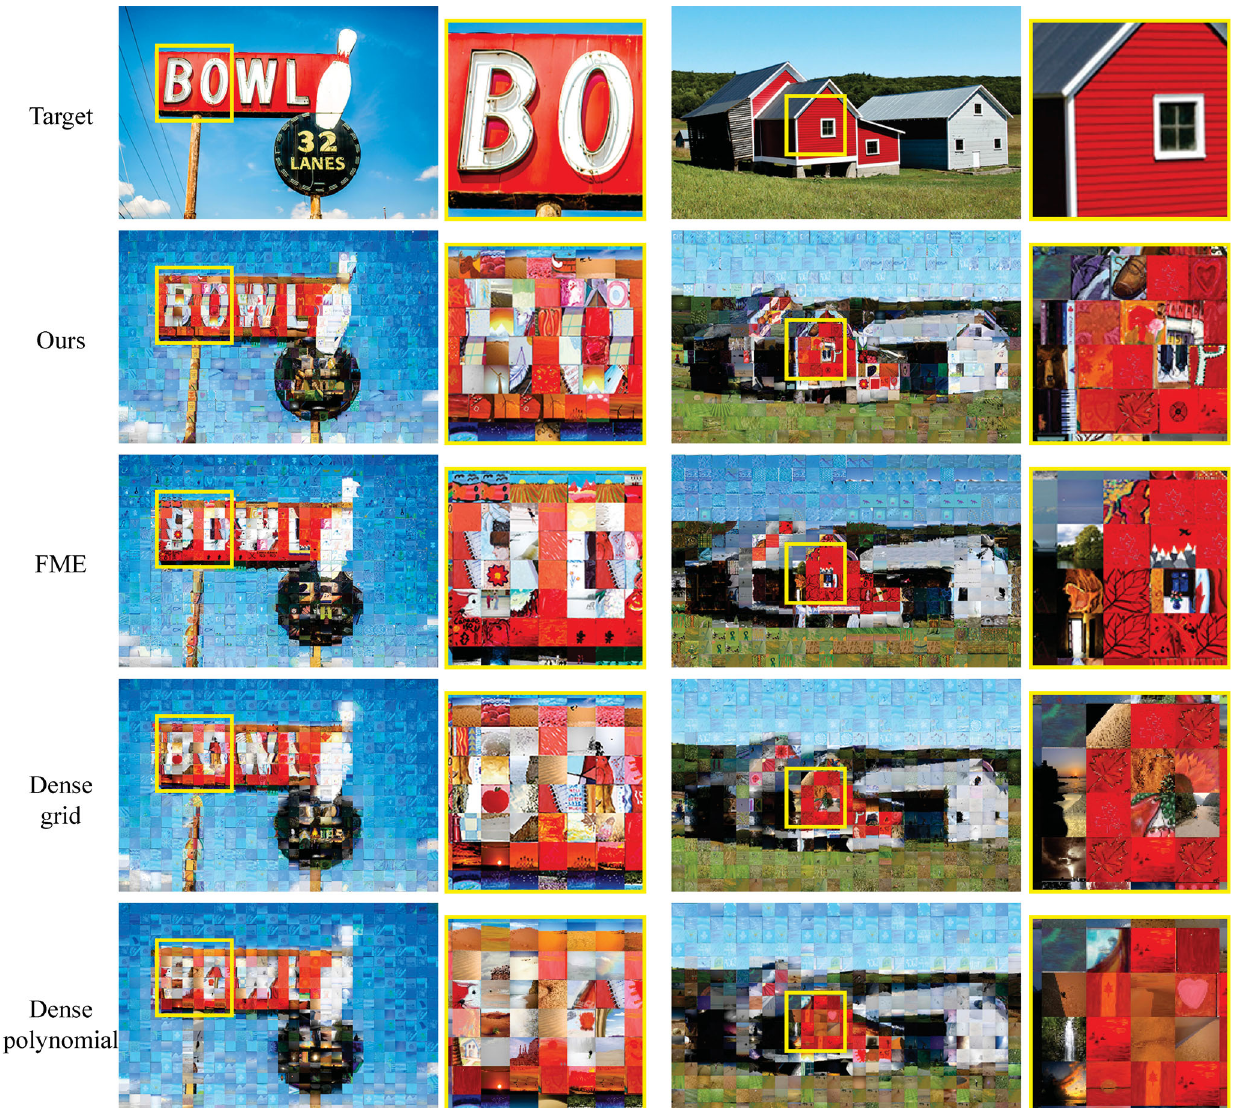
Fig. 7 Comparison with existing methods. Our method results in best edge